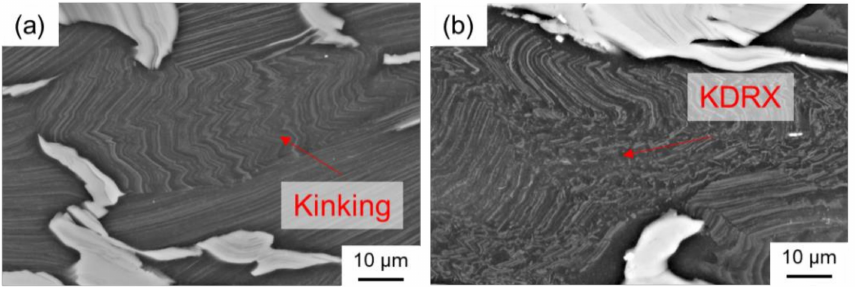
Figure 9. SEM images (20 kV, BSD) of deformed samples of the as-cast condition: ( a ) kinking at 350 °C and ( b ) kink-aided dynamic recrystallization at 450 °C .